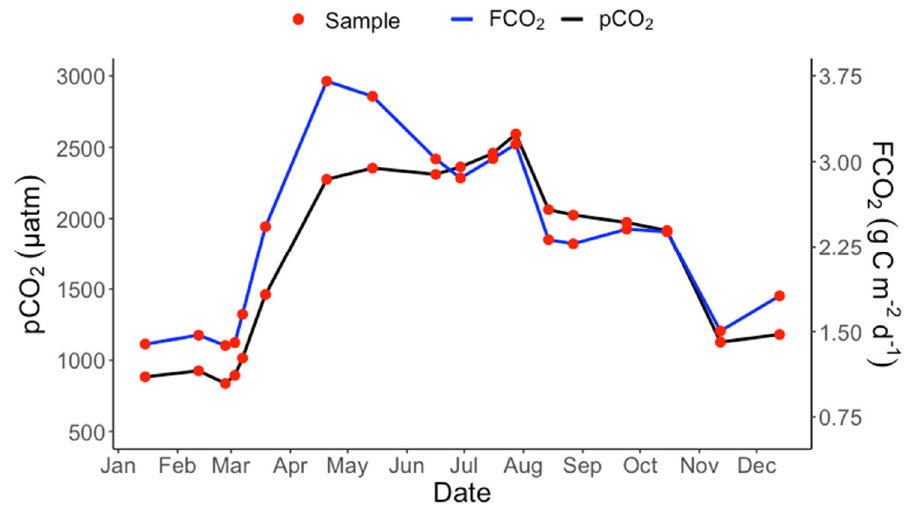
Figure 3. Seasonal trend of p CO 2 and CO 2 outgassing from the Mississippi River at Baton Rouge, Louisiana.